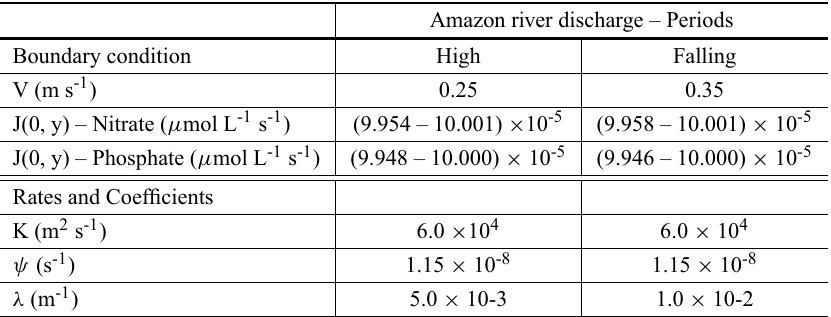
Boundary condition values, rates and coefficients used in the simulations with the MAAC-2D